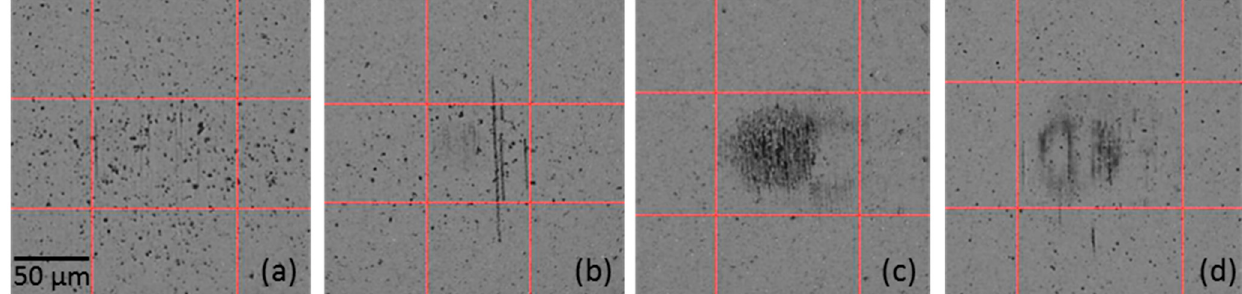
Figure 8. OM images of the wear scars on the Si 3 N 4 ball surface formed after lubricated sliding on: ( a ) the original surface at T = 23 °C, R = 7 mm, ( b ) laser-textured surface at T = 23 °C, R = 4.5 mm, ( c ) laser-textured surface at R = 3 mm in the first series of the successive tests at different temperatures, and ( d ) in the repeated tests at R = 3 mm at different temperatures.